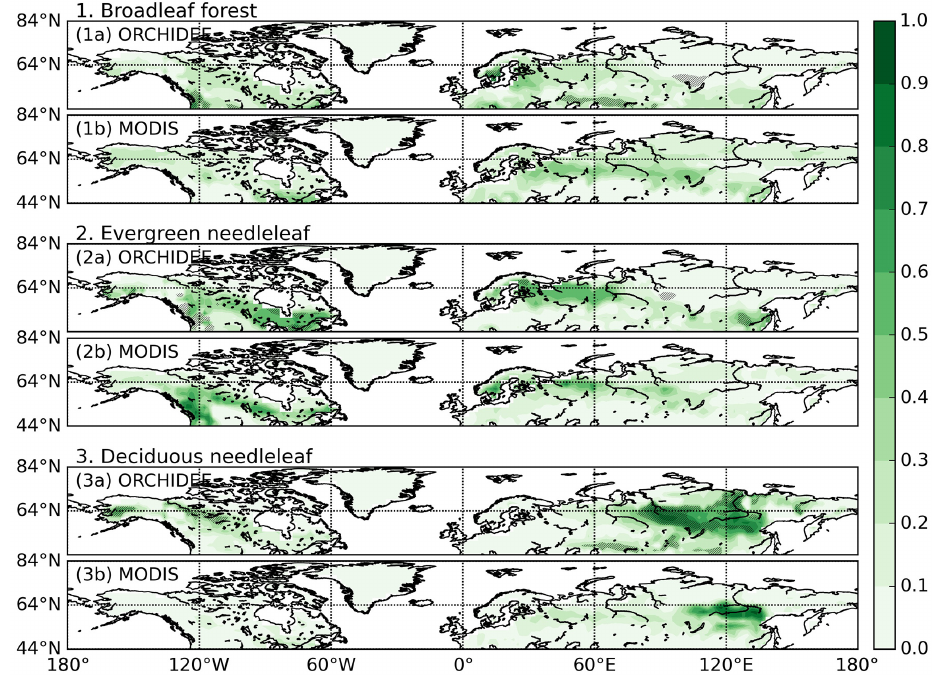
Figure 3. Spatial distribution of three different tree groups with the coverage as a fraction of ground area for (1) broadleaf, (2) evergreen needleleaf and (3) deciduous needleleaf by (a) ORCHIDEE simulation and (b) MODIS land-cover data for year 2010. Hatched areas show where the two data sets differ by >30% of ground